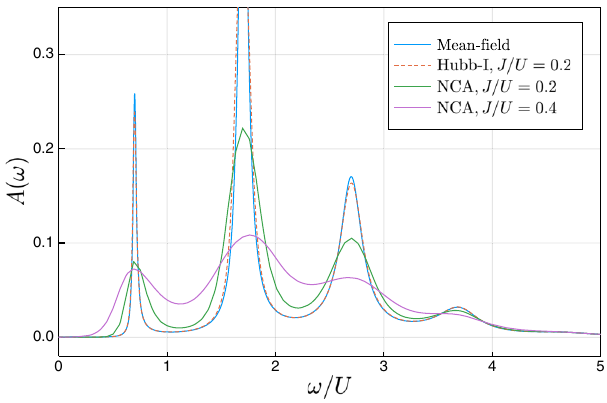
FIG. 5. Local spectral function A ð ω Þ for different values of J=U , as computed within Gutzwiller mean-field theory (blue line), DMFT with Hubbard-I impurity solver (dashed red line) and NCA impurity solver (green and violet full lines), for fixed z ¼ 6 and r ¼ 0 . 6 . Gutzwiller results show a series of narrow peaks broadened by the local dissipation only. DMFT instead is able to capture additional broadening processes, already evident for J=U ¼ 0 . 2 within Hubbard-I, which, however, largely underestimates the effect of the non-Markovian bath as con- firmed by the comparison with the more accurate NCA. 10 Parameters: dim H ¼